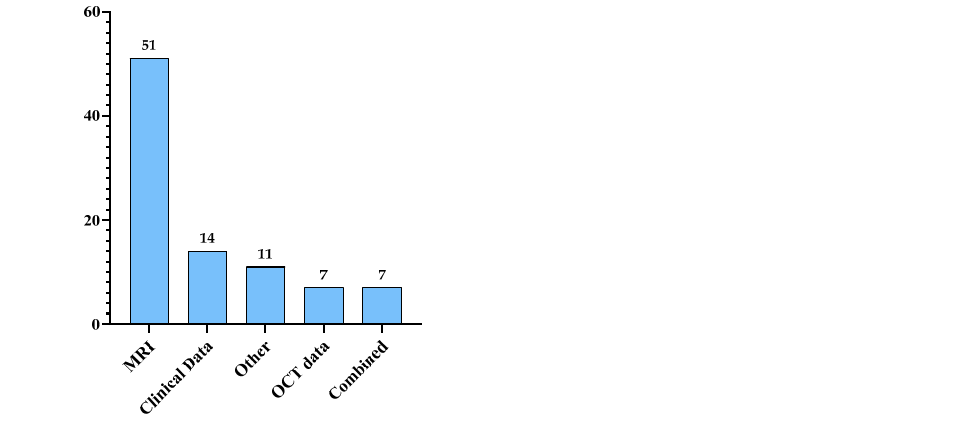
Figure 1. Distribution of the previous studies based on the data modalities used for the MS diagno- sis. Table 5. Summary of the previous studies that used clinical data. Ref.